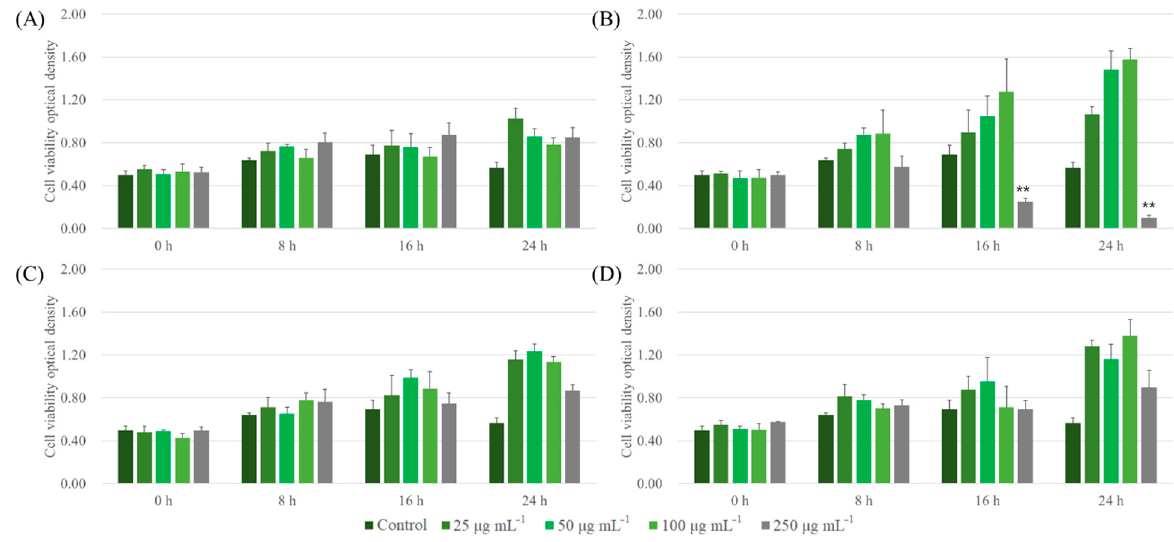
Figure 6. Cytotoxic effect of ALNPs on LLC cells determined by the Cell Counting Kit-8 assay. ( A ) ALNP-C4, ( B ) FALNP1, ( C ) FALNP2, and ( D ) FALNP3. All data sets were compared to the blank control (serum-free DMEM containing 1% of antibiotic–antimycotic solution). The levels of significant differences were set at probabilities of * p < 0.05, ** p < 0.01, and *** p < 0.001.